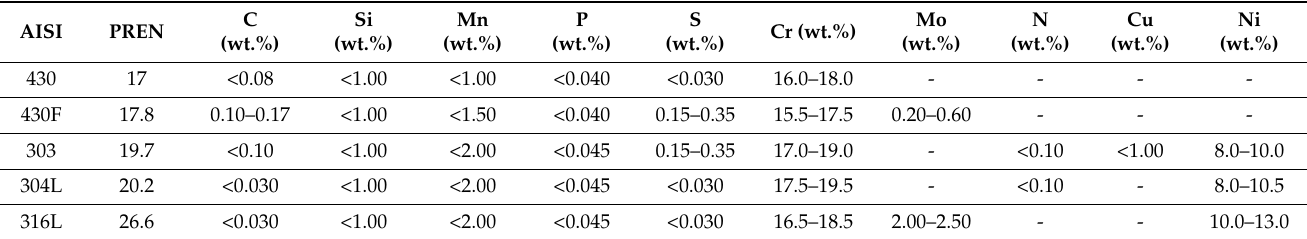
Table 1. PREN and chemical composition (% weight) of SS